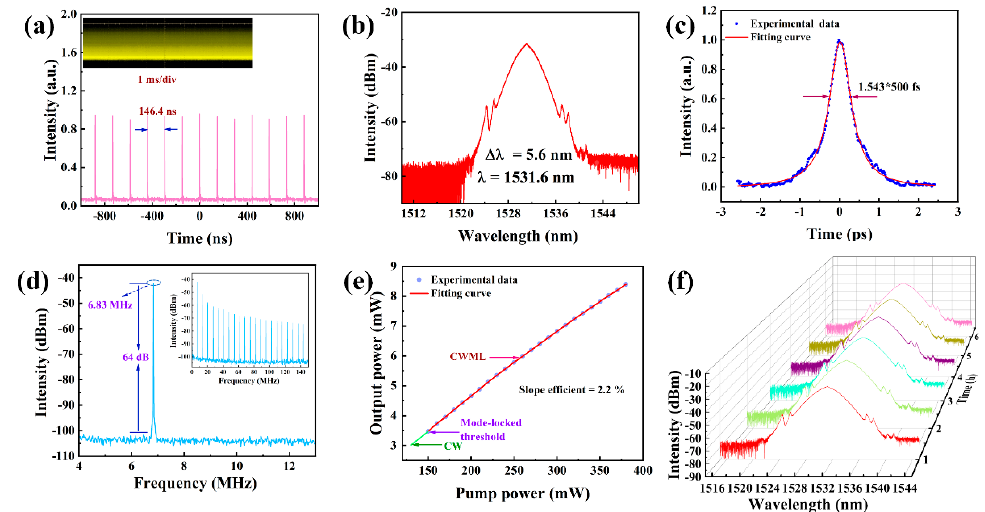
Figure 7. Classical mode-locked output characteristics: ( a ) pulse train; ( b ) optical spectrum; ( c ) pulse width; ( d ) RF spectrum (inset: broadband RF spectrum); ( e ) relative change of output power and pump power; ( f ) long-period spectroscopic measurement (1-h intervals, 6 h in total).